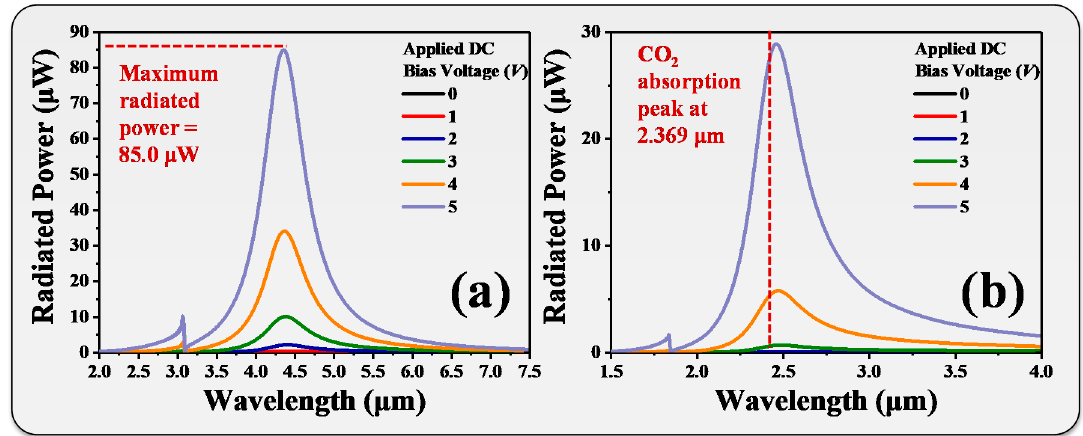
Figure 7. Radiated powers of the tunable emitter with ( a ) n 2 = 1.542 and ( b ) n 2 = 0.920 at different driving DC bias voltages for IR emitting and gas sensing applications.